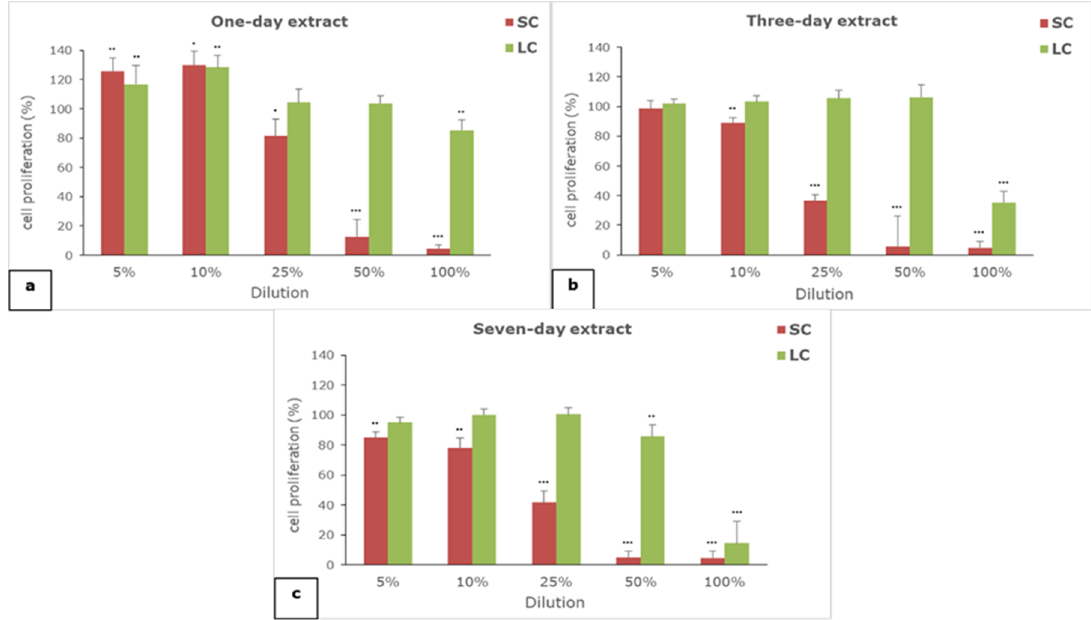
Figure 2. The effect of ( a ) one-, ( b ) three-, and ( c ) seven-day extracts of materials on the proliferation of L929 cells; SC—self-curing material; LC—light-curing material; (*) p < 0.05, (**) p < 0.01, (***) p < 0.001.